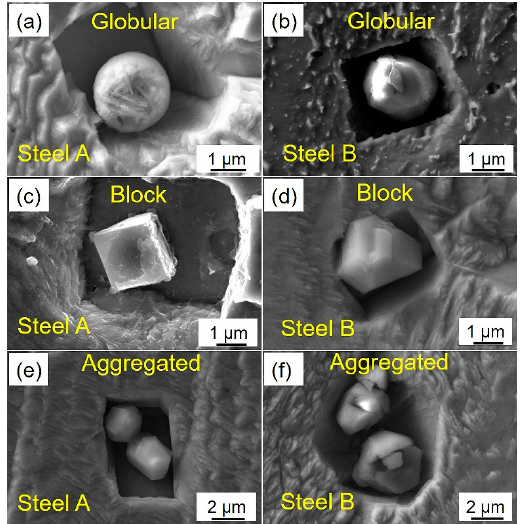
Figure 6. Typical morphologies of Al 2 O 3 inclusions with different shapes in the molten steel of ( a – d ) RH ending; ( e, f ) tundish outlet for Steels A and B.